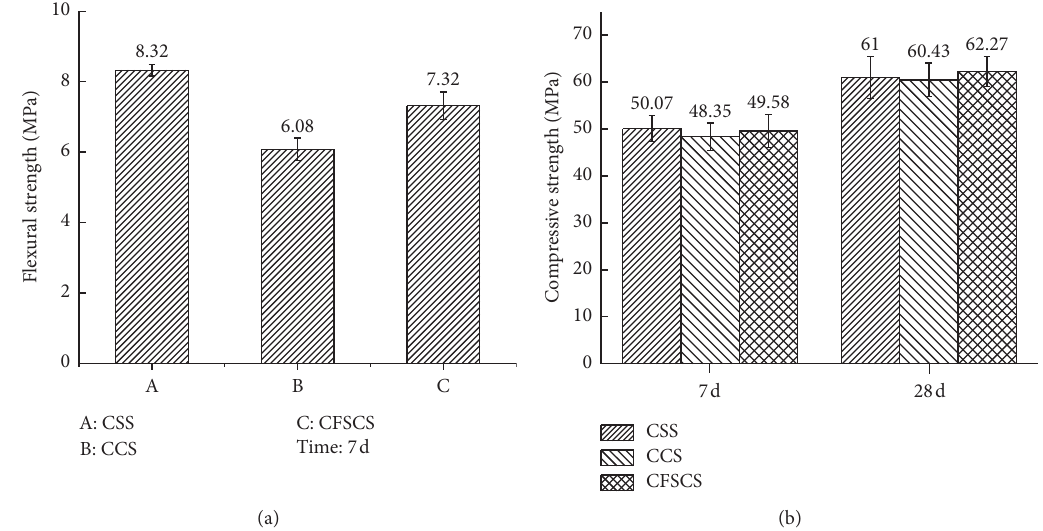
Figure 6: Flexural (a) and compressive (b) strengths of mortar samples at 7d and 28d. CSS: standard mortar; CCS: coral mortar; CFSCS: coral mortar with 15% fly ash and 15%